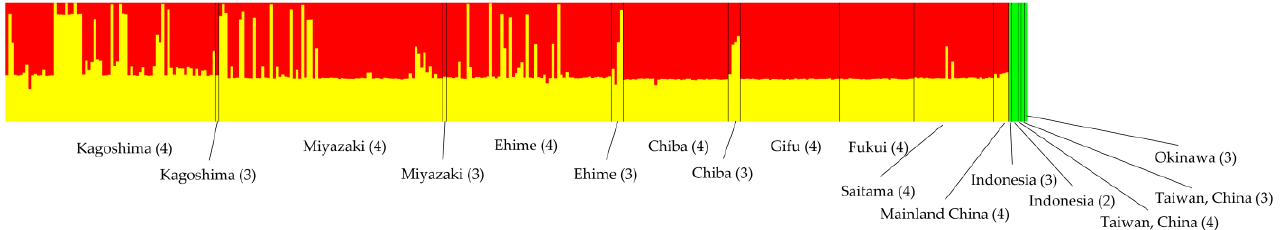
Figure 4. PCA plot of Nei’s standard genetic distance calculated by PolyGene software. Circles show the grouping of the isolates.